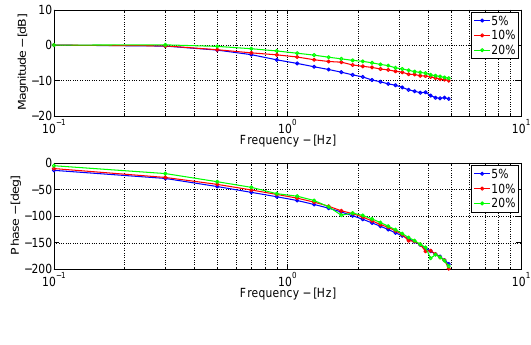
Figure 7: Test results in 50% positive offset.